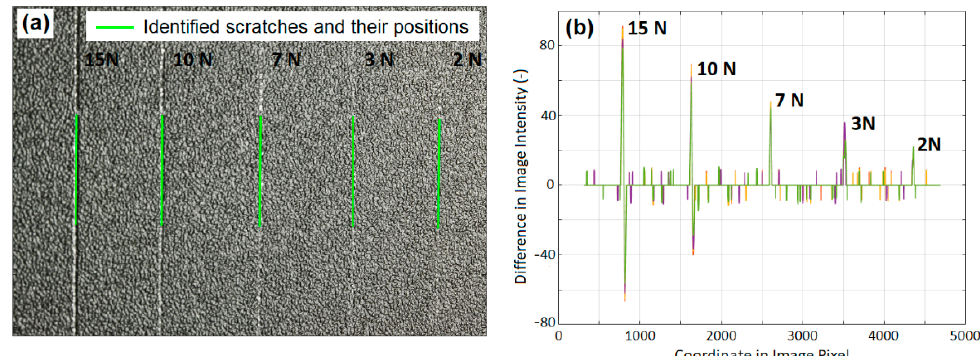
Figure 2. ( a ) Scratches identified and their positions (indicated by short green lines) on SB texture, and ( b ) Image intensity difference in contrast to background for calculating the properties of the scratches.